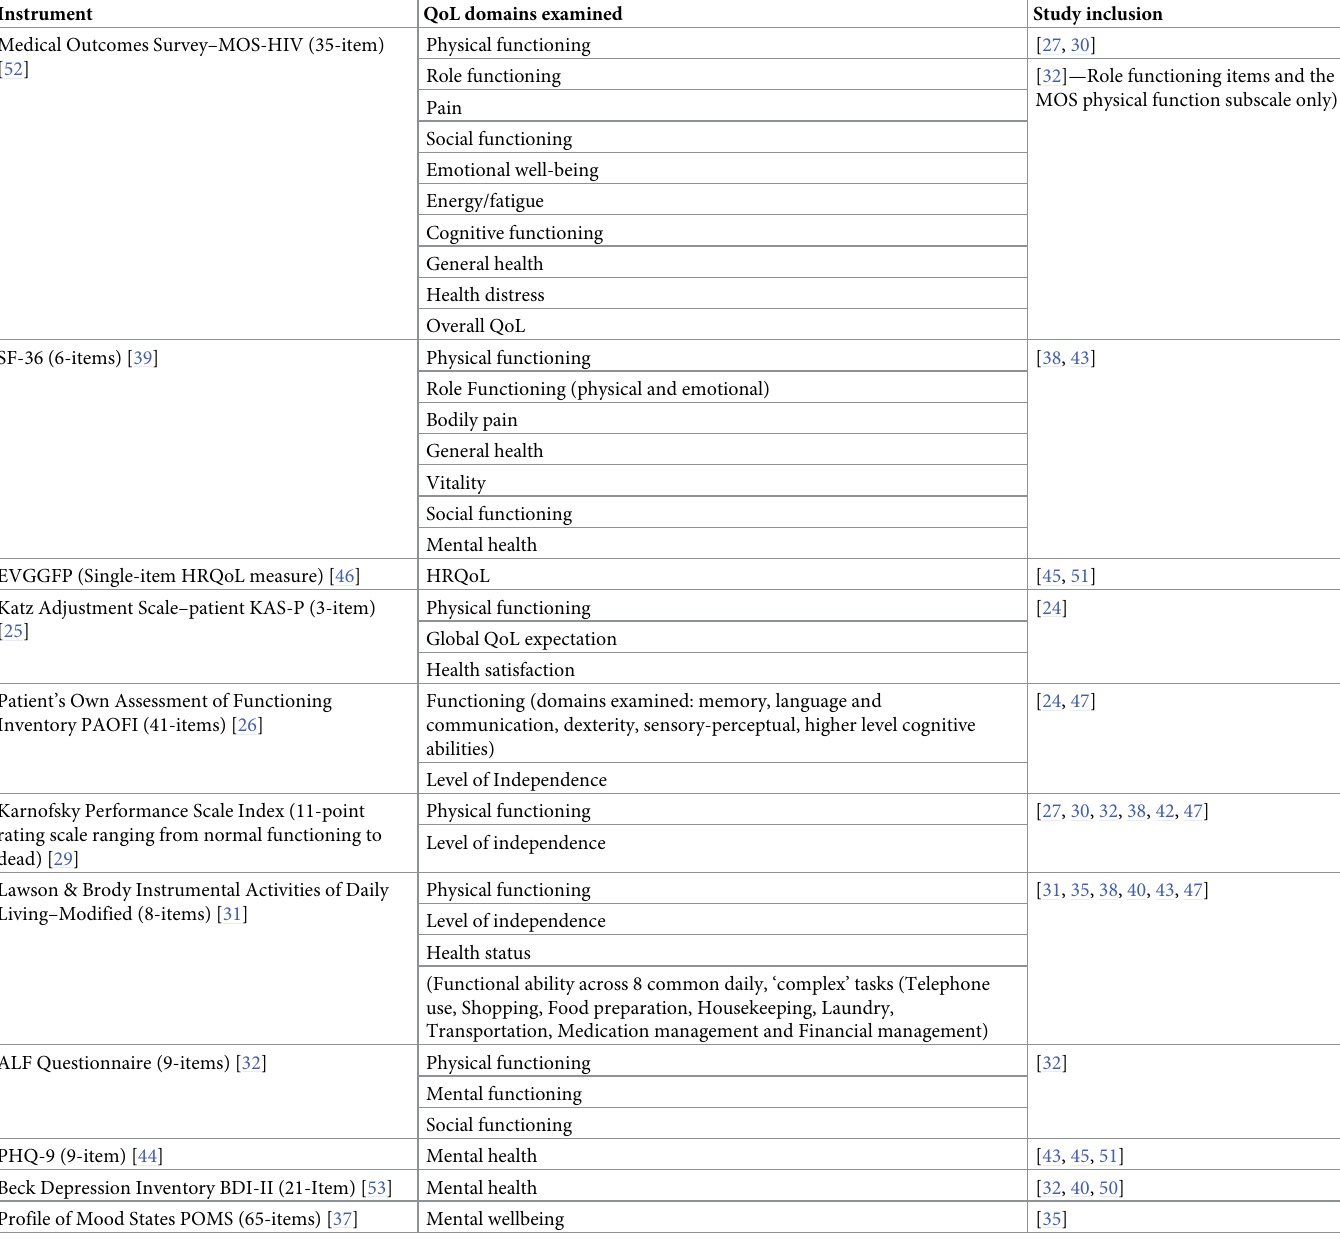
Table 3. QoL measures and